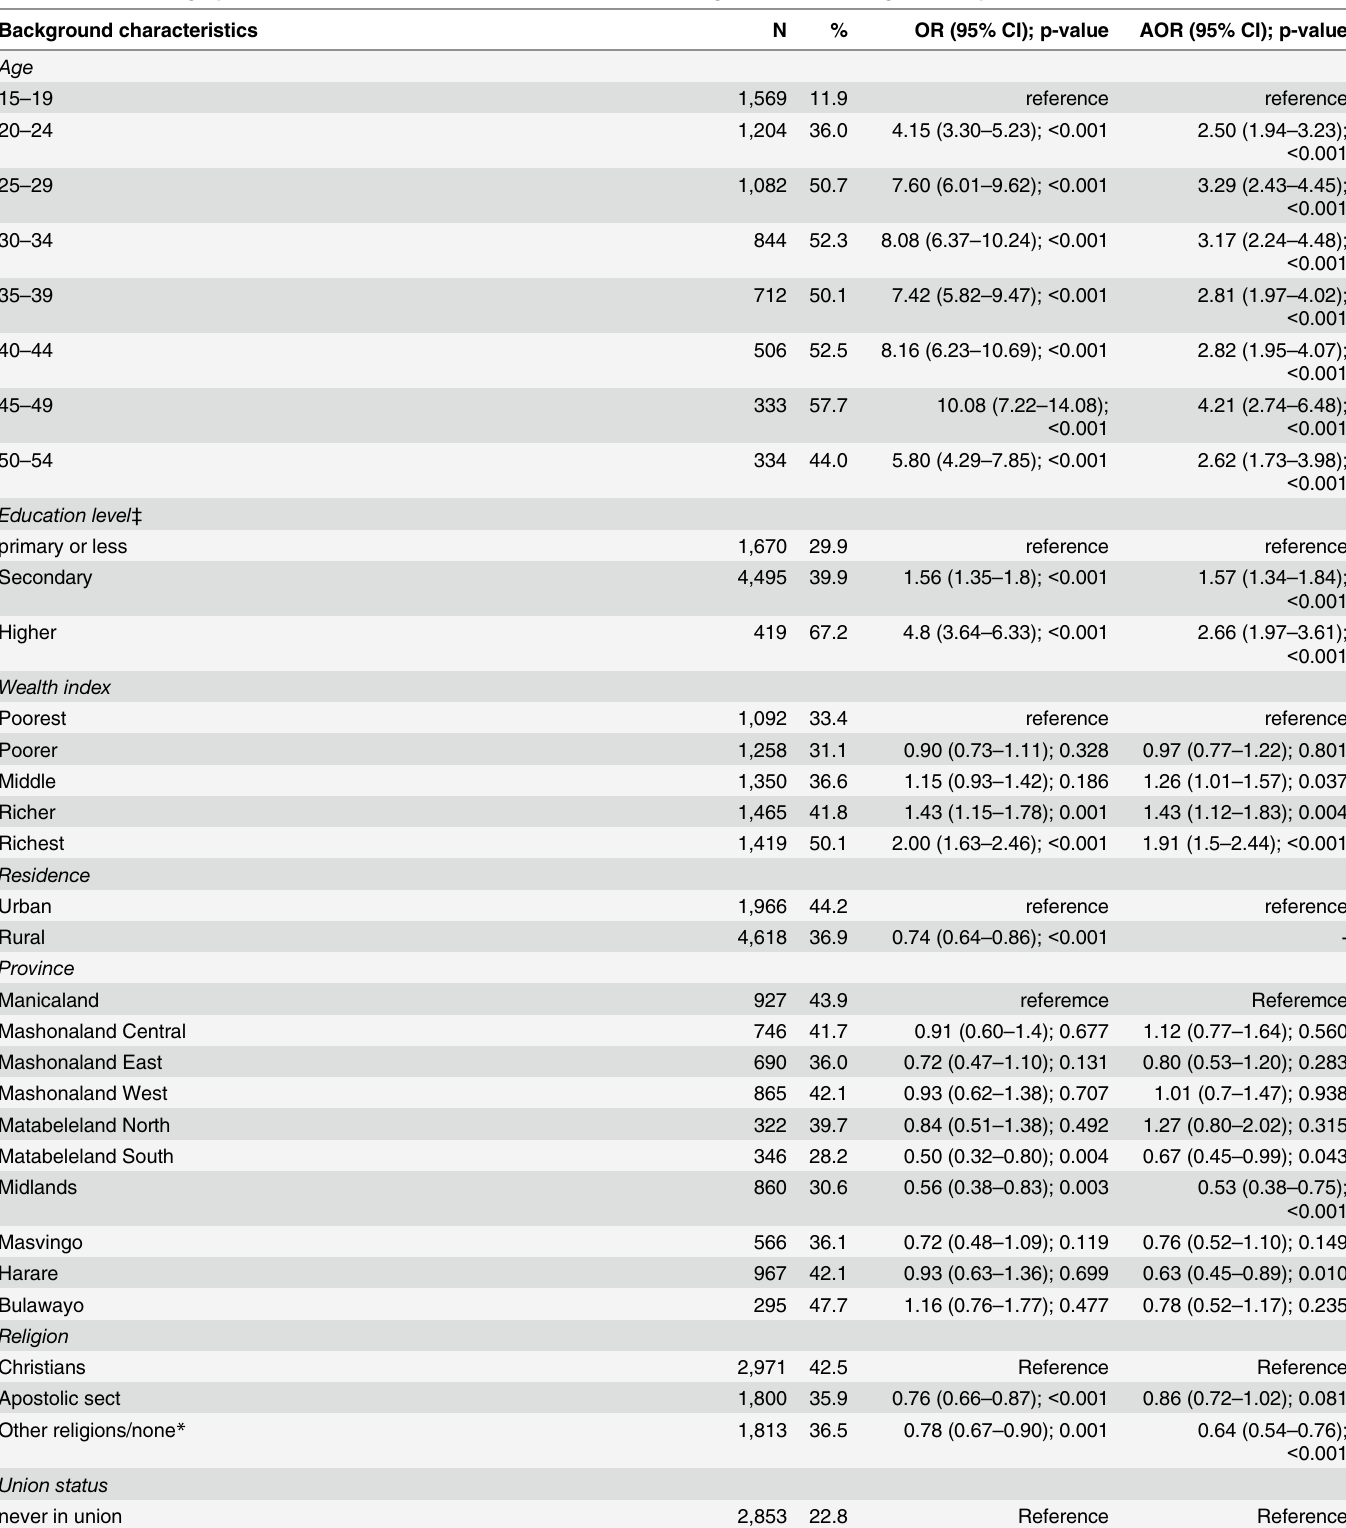
Table 3. Sociodemographic and sexual risk factors associated with ever being HIV-tested among male respondents, ZDHS 2010 – 11. Background